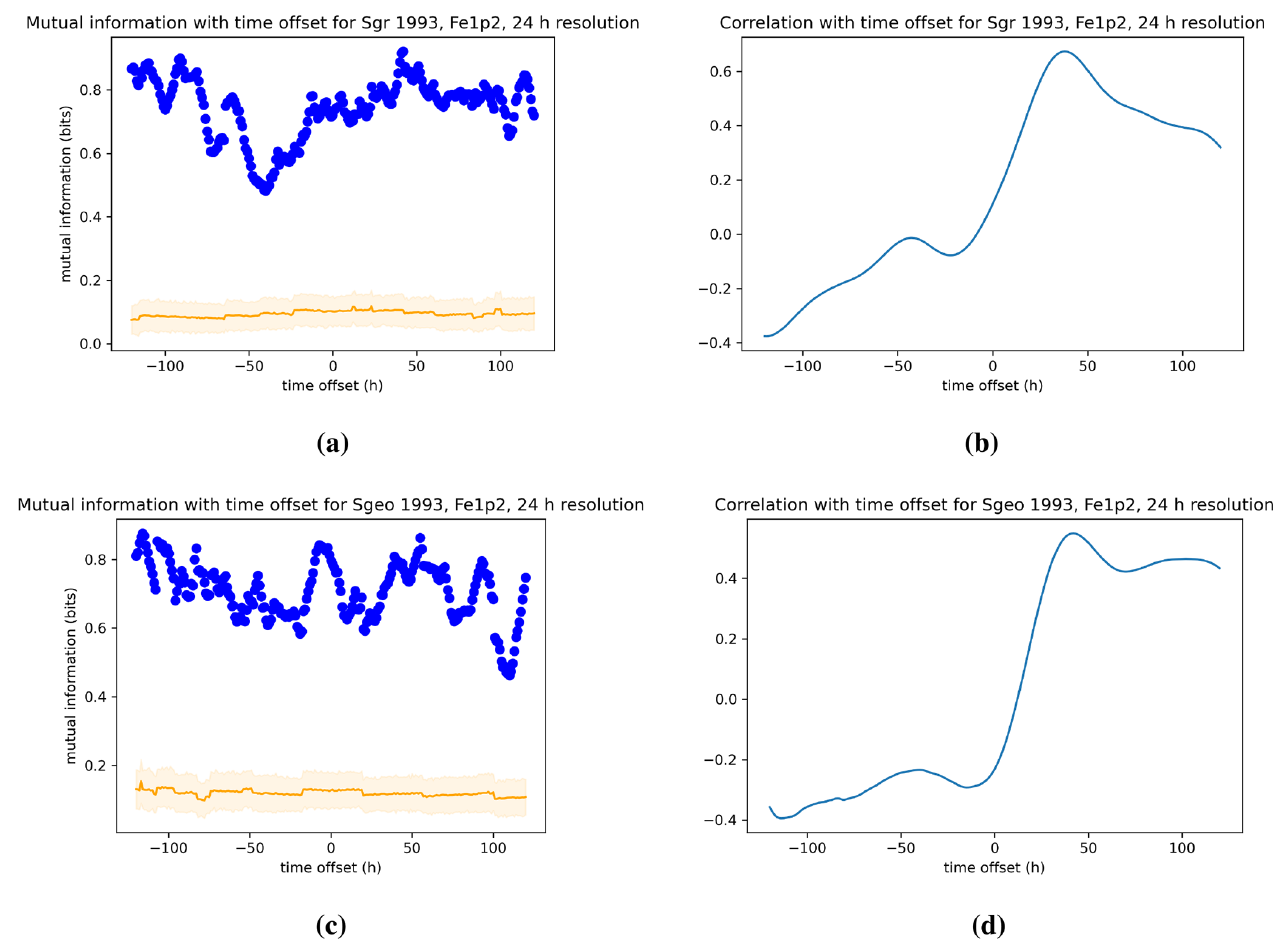
Figure 7. Same as in Fig. 5 but for the 1993 event of Rostoker et al.